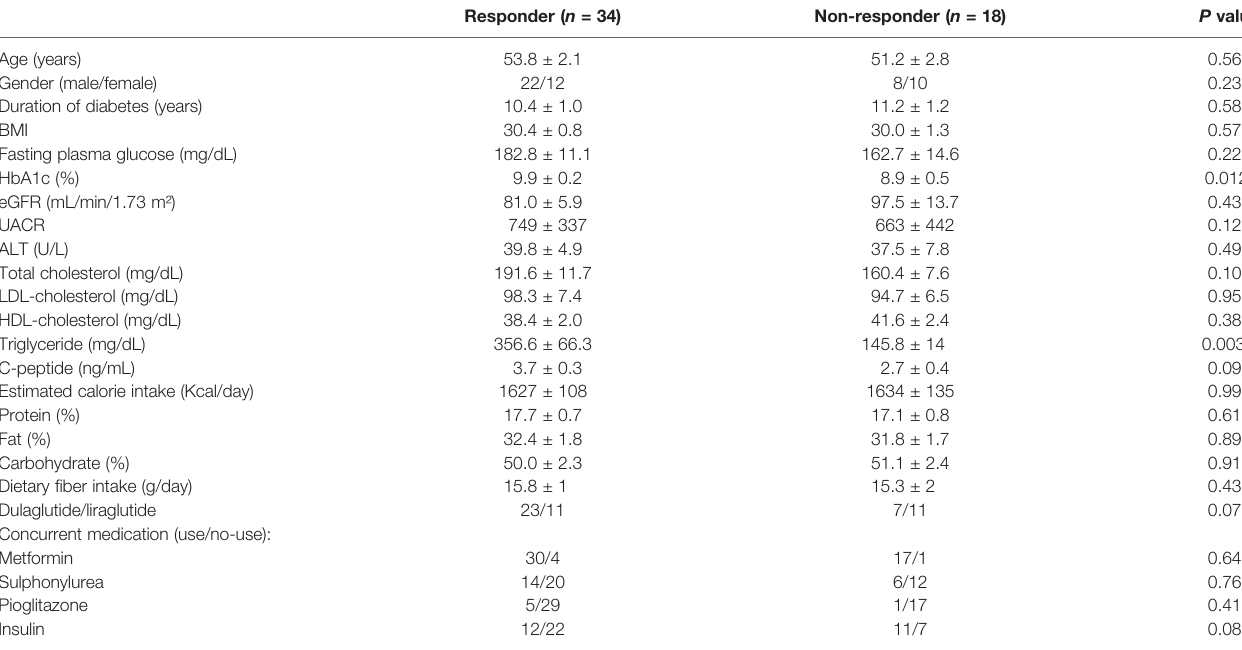
TABLE 1 | Clinical characteristics of type 2 diabetic patients receiving GLP-1 RA